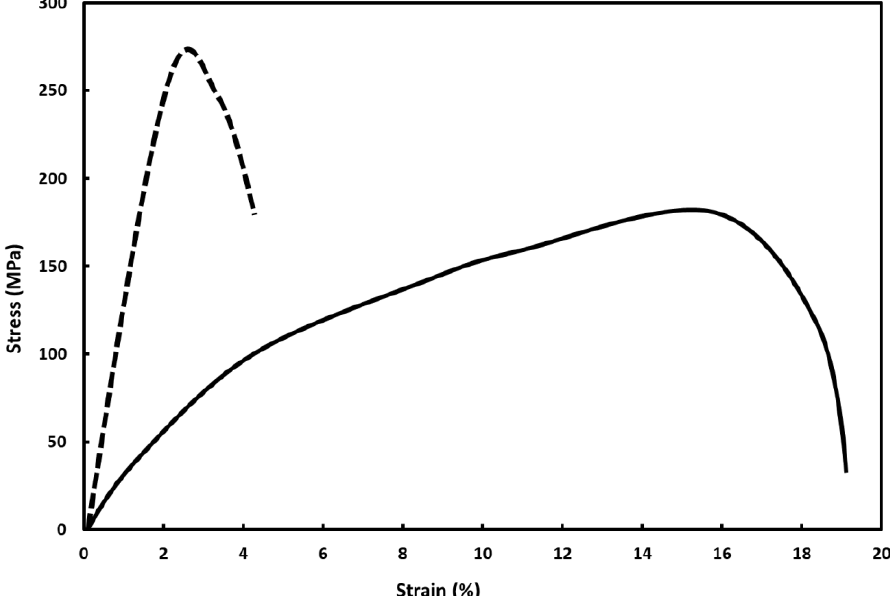
Figure 1. Representative engineering stress–strain curves for vacuum-annealed (solid curve) and hydrogen-cycled at 298 K (dashed curve) palladium–copper (5 wt.% copper) alloy.